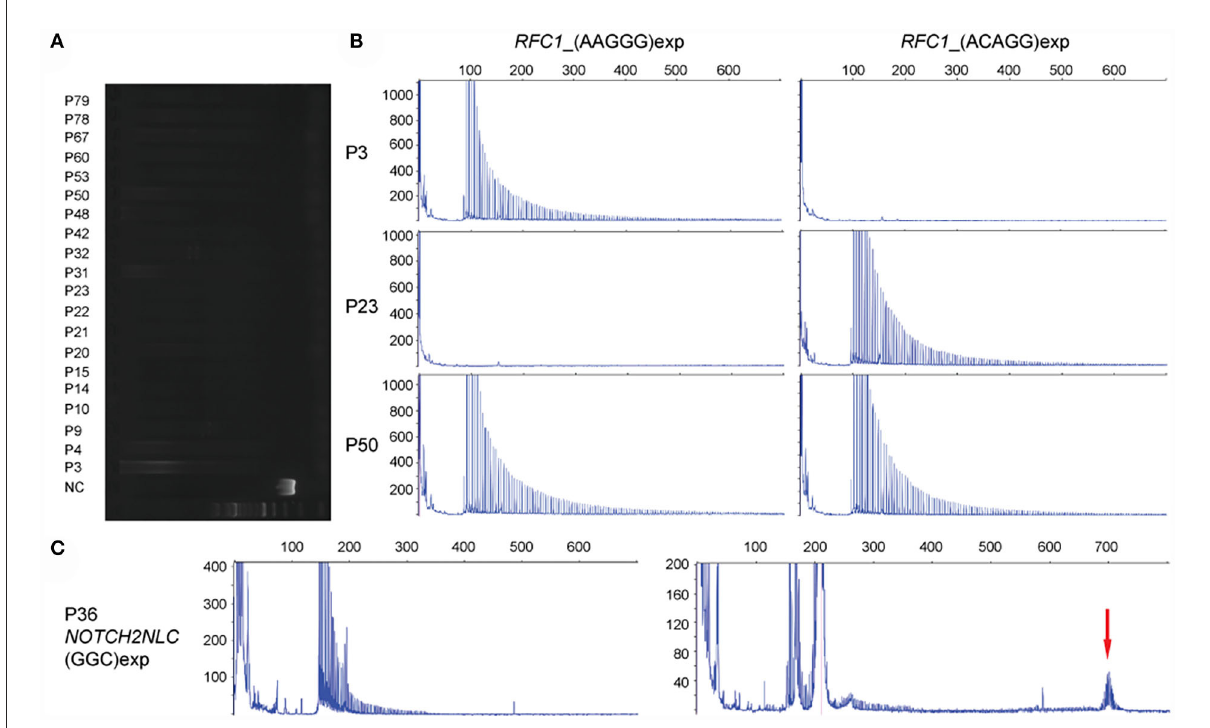
FIGURE2 Detection of disease-associated repeat expansions in RFC1 and NOTCH2NLC genes. (A) Long-range PCR shows the absence of clear amplifiable PCR product in RFC1 from 20 cases with HSAN. NC: negative control. (B) Examples of [(AAGGG)exp/(AAGGG)exp] (P3), [(ACAGG)exp/(ACAGG)exp] (P23), and [(AAGGG)exp/(ACAGG)exp] (P50) of RFC1 , in the decremental saw-tooth pattern. (C) Repeat-primed PCR reveals (GGC)exp in NOTCH2NLC (P36), and amplicon length is determined by fluorescence amplicon length analysis (red